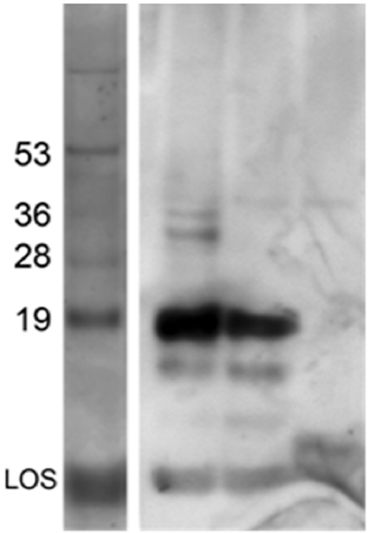
Figure 3. Vesicles contain immunogenic proteins. Samples were analyzed after electrophoresis through a 16.5% Tris–Tricine gel. Western blotting of vesicle-containing fractions (lane 1), lysate (lane 2), and culture supernatant (lane 3). Protein standards were spiked with LOS isolated from F62 Δ lgtDfix. Components in the Western blot were detected using a polyclonal sera raised against whole cell GC.